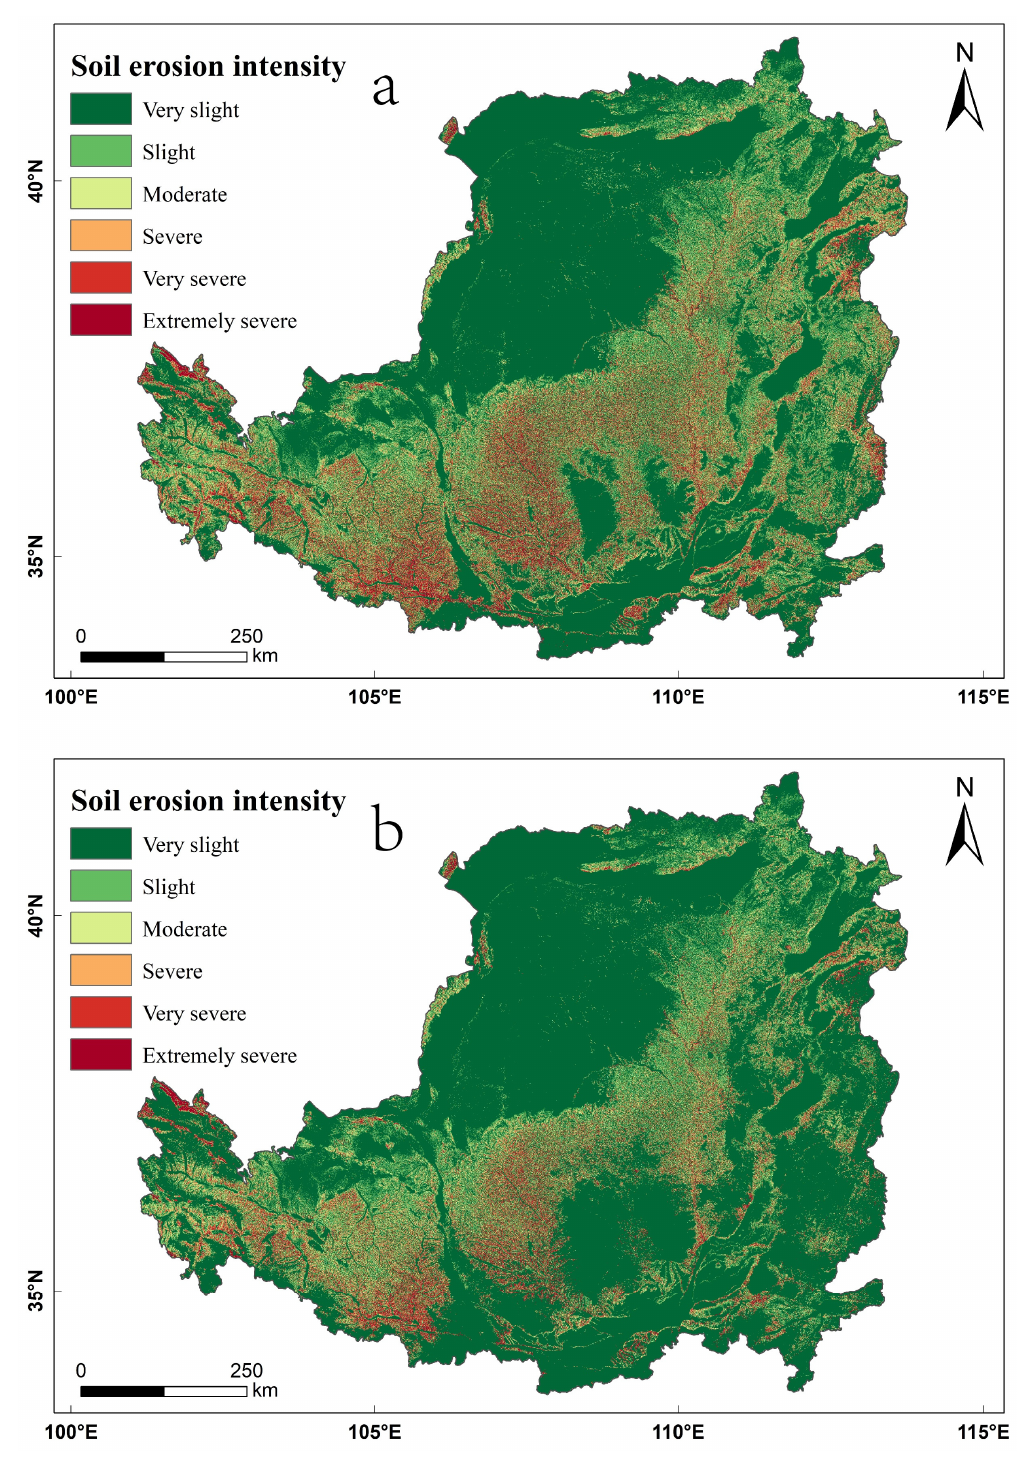
Figure 7. Distribution of soil erosion intensity in the Loess Plateau in ( a ) 2000 and ( b ) 2018.